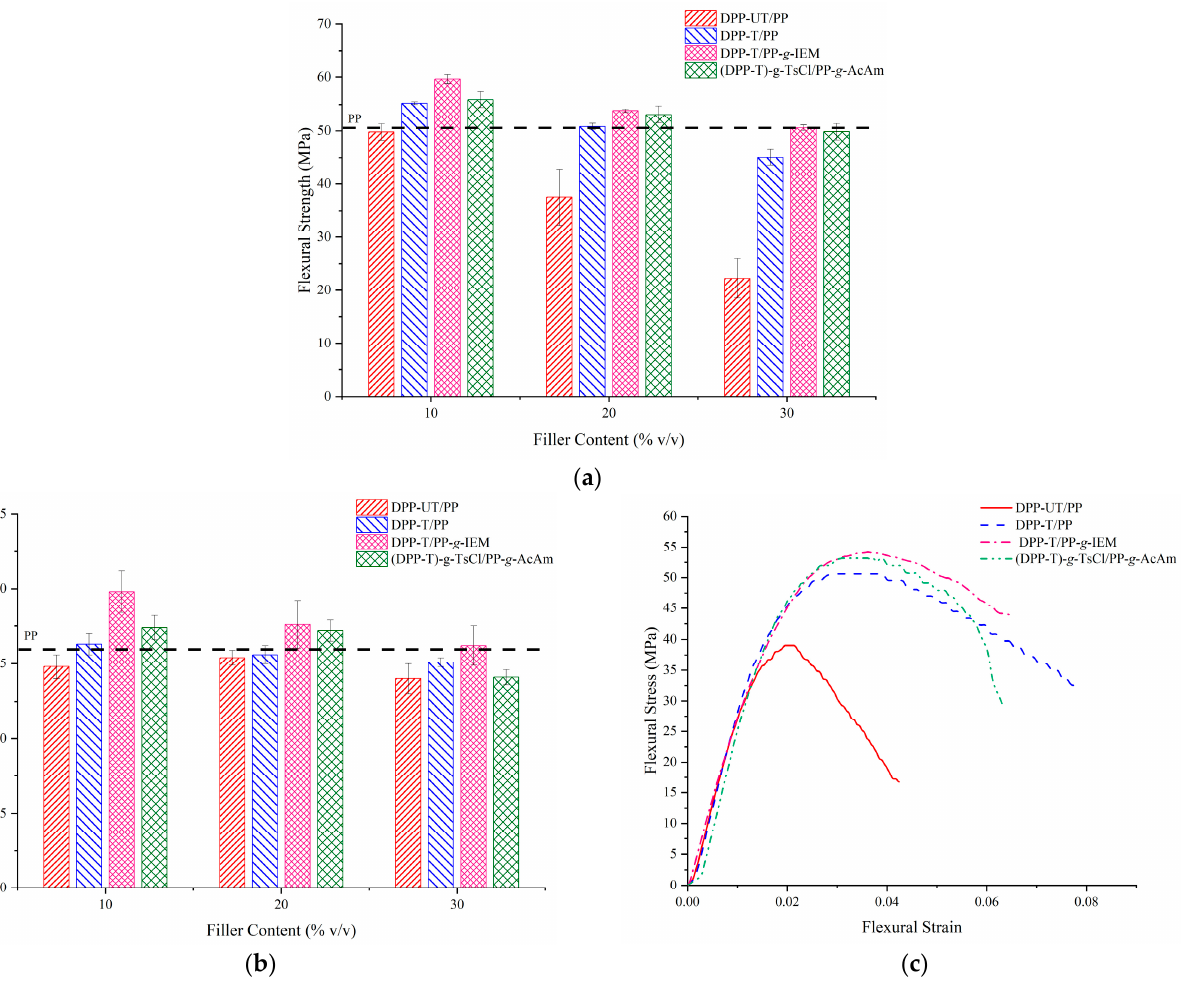
Figure 10. The flexural properties of the developed bio-composites at 20% DPP filler content: ( a ) flexural strength; ( b ) flexural modulus; ( c ) stress–strain curve.